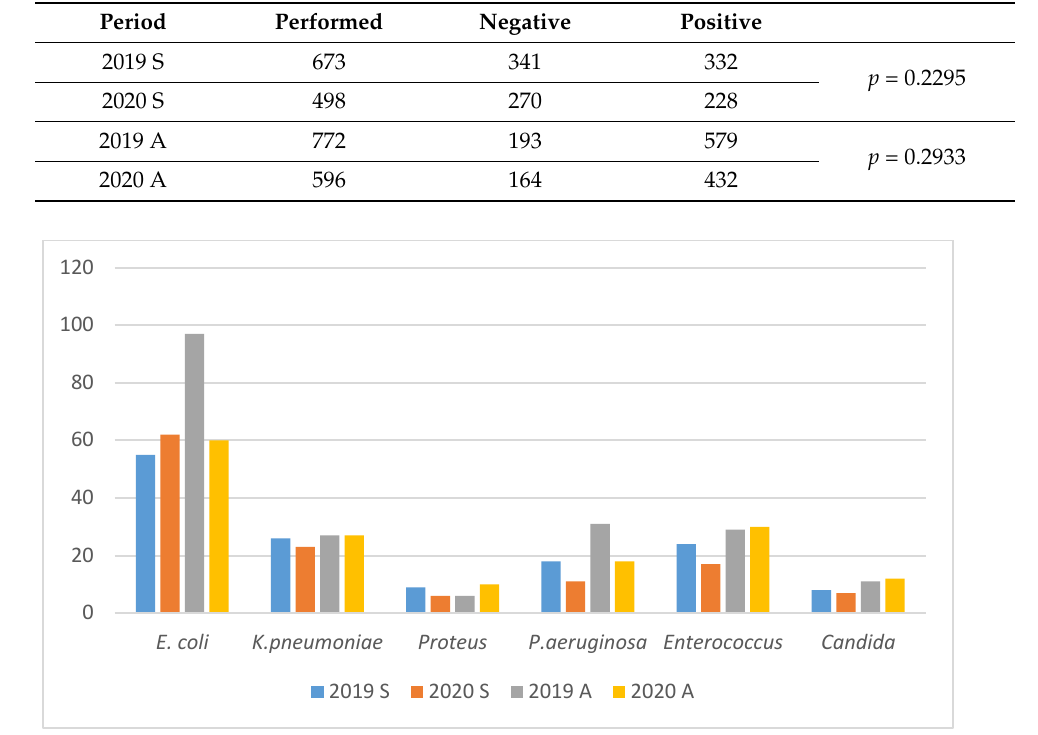
Table 3. Urine cultures.